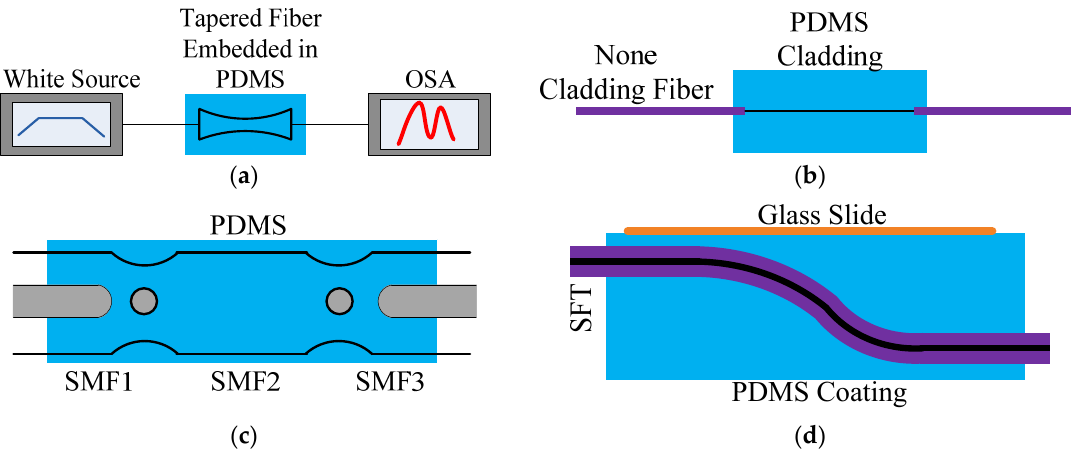
Figure 2. The fiber sensors coated with PDMS: ( a ) Tapered fiber embedded in PDMS [21]; ( b ) Core-fiber with PDMS cladding [22]; ( c ) Bowknot taper fiber coated with PDMS [23]; ( d ) S-shaped taper fiber coated with PDMS [24].